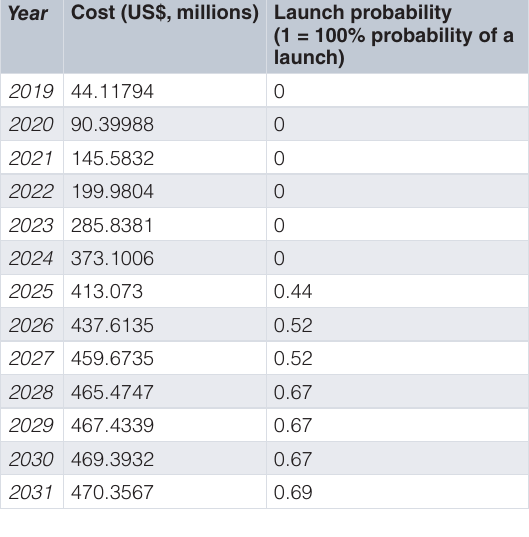
Table 6. Cost and annual launch probability by